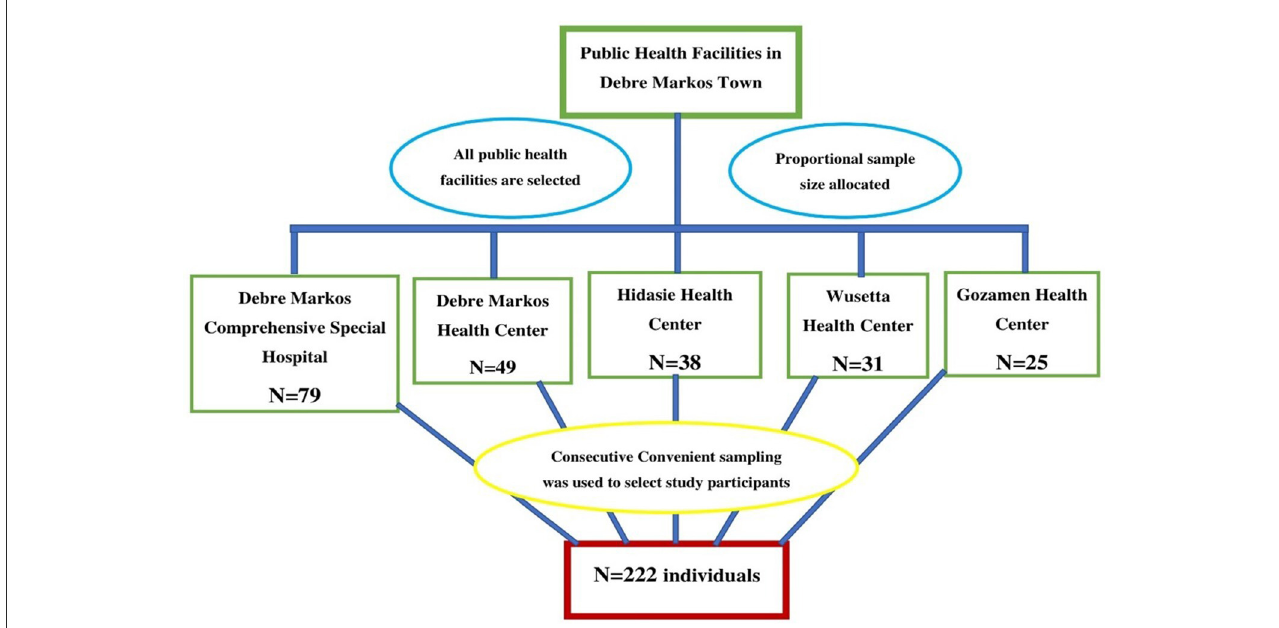
FIGURE1 Proportional allocation of study participants among public health facilities in Debre Markos town, 2022.